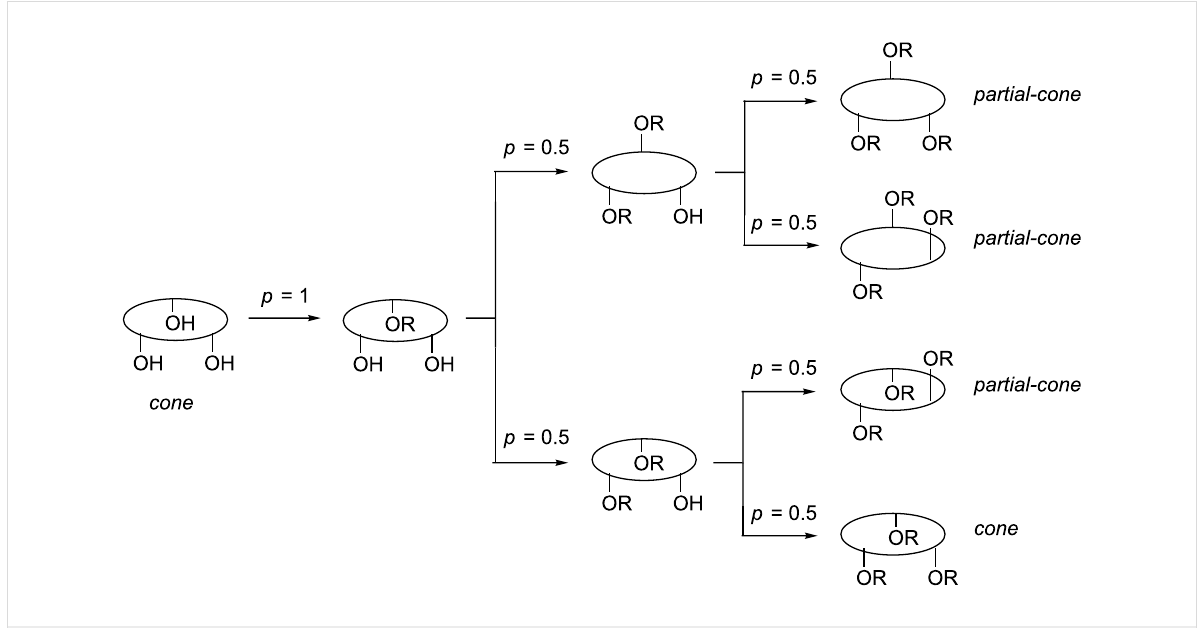
tion is relatively straightforward, but conformational control is harder to achieve. The main drawback of lower-rim